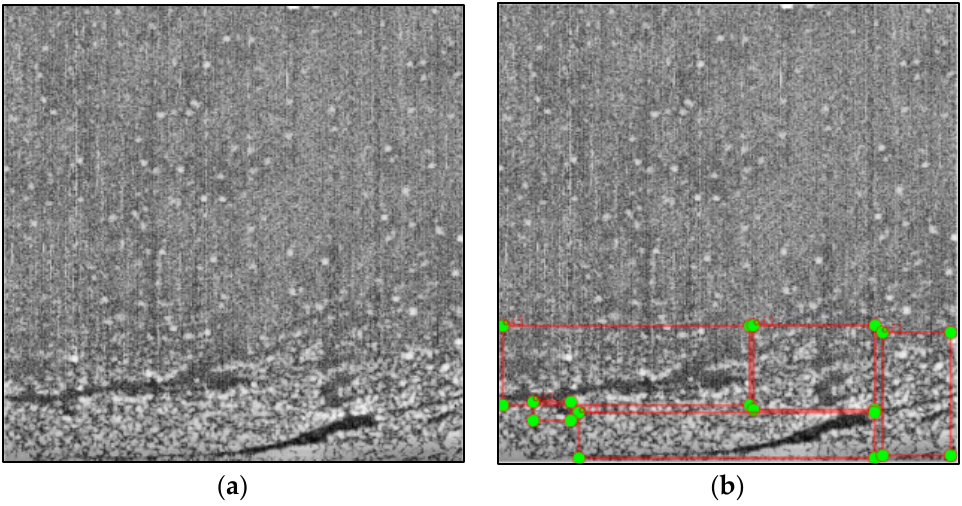
Figure 6. Oil fi lm labelling in the marine radar preprocessed image. ( a ) Preprocessed image tile sample; ( b ) Oil spill labels.